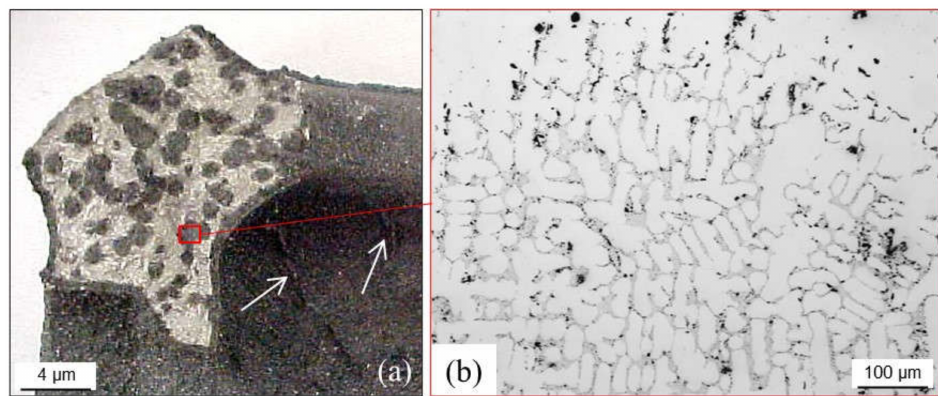
Figure 74. ( a ) Macroscopic view of fields with graphite precipitates in the heaviest section of a white iron casting. ( b ) Metallographic view of graphite particles found in one of these fields. Graphite precipitation in white iron castings is triggered by too high carbon contents in melts ( ≥ 3 wt.%), low contents of those alloying elements used to promote white solidifi- cation (Cr, Mo, Bi, etc.) and low cooling rates which promote stable solidification. Figure 75 shows the influence of carbon and silicon contents on white or graphitic solidification in the preparation of malleable cast irons [52].